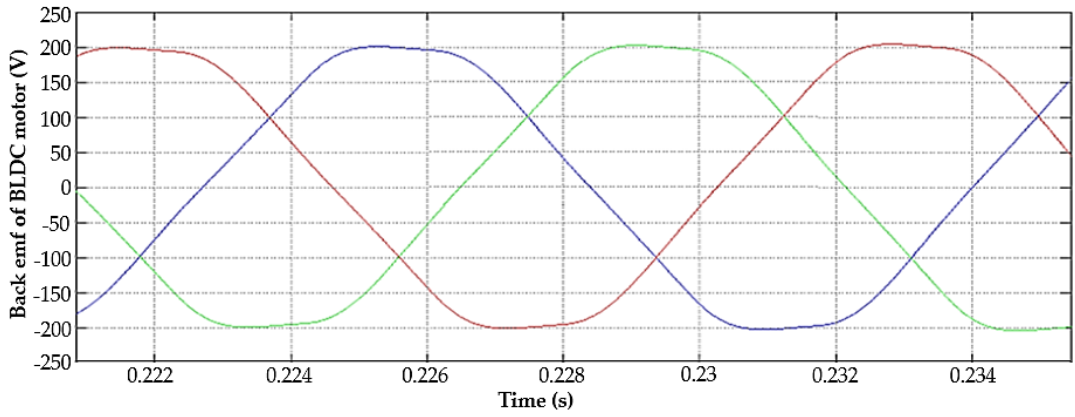
Figure 9. The back emf of the BLDC motor.